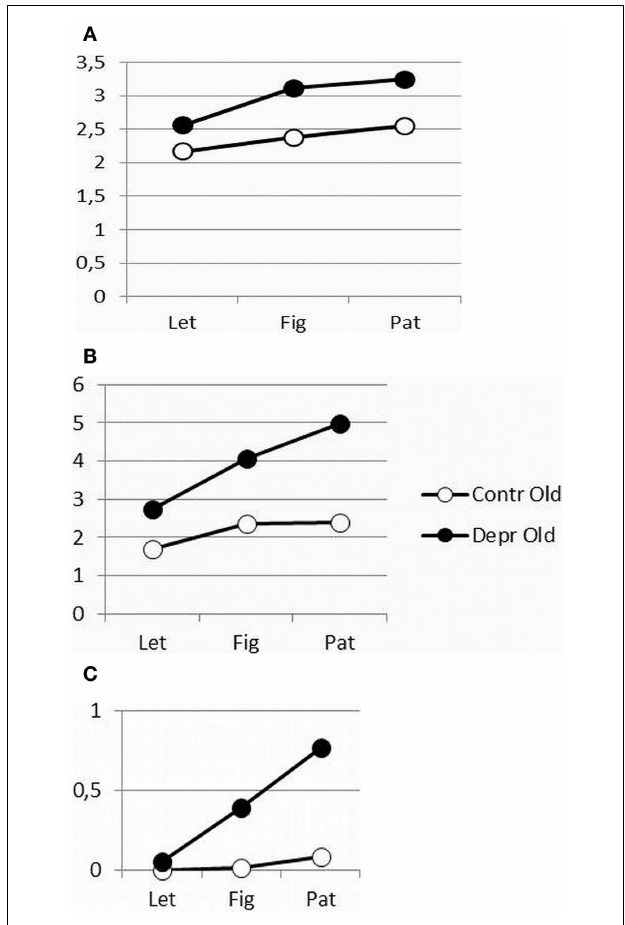
FIGURE 2 | (A–C) Differences in initiation time (A) , movement time (B) , and reinspection time (C) as a function of complexity between depressive patients and healthy controls.